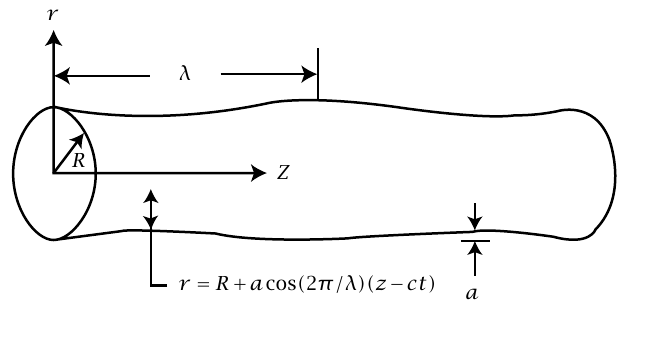
Figure 2.1 . Geometry of the